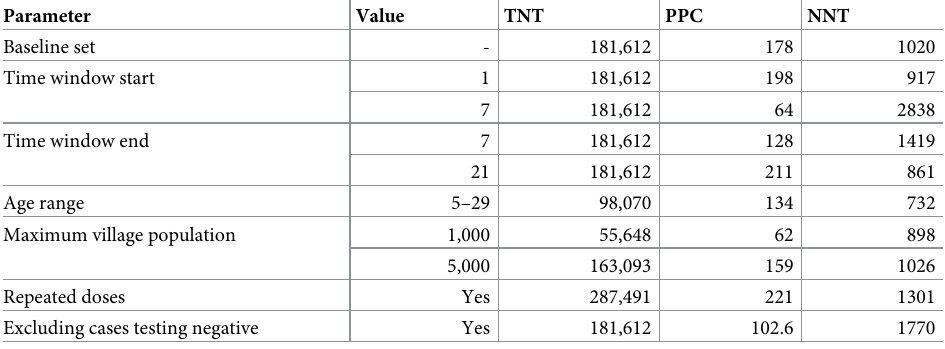
Table 4. Potential effectiveness and efficiency of village-prophylaxis strategies across a range of parameters. Parameter Value TNT PPC NNT Baseline set - 181,612 178 1020 Time window start 1 181,612 198 917 7 181,612 64 2838 Time window end 7 181,612 128 1419 21 181,612 211 861 Age range 5–29 98,070 134 732 Maximum village population 1,000 55,648 62 898 5,000 163,093 159 1026 Repeated doses Yes 287,491 221 1301 Excluding cases testing negative Yes 181,612 102.6 1770 Total number treated, potentially prevented cases, and number needed to treat under a range of